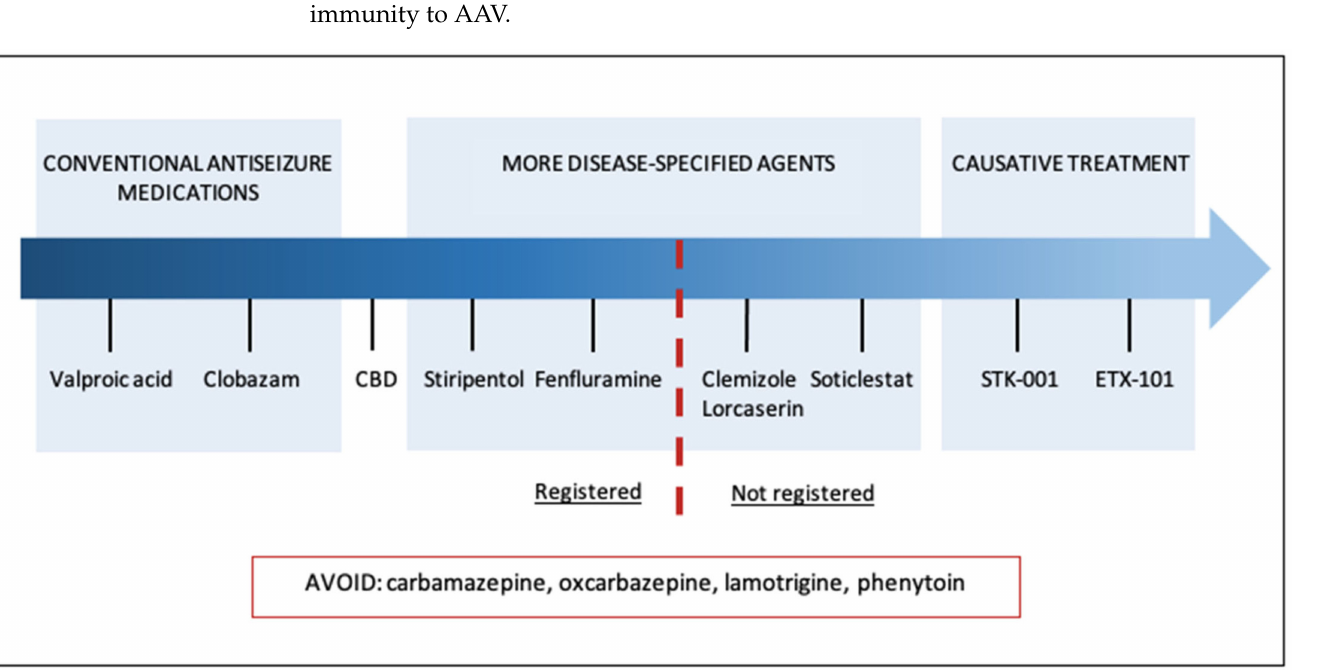
Figure 1. The landscape of Dravet Syndrome